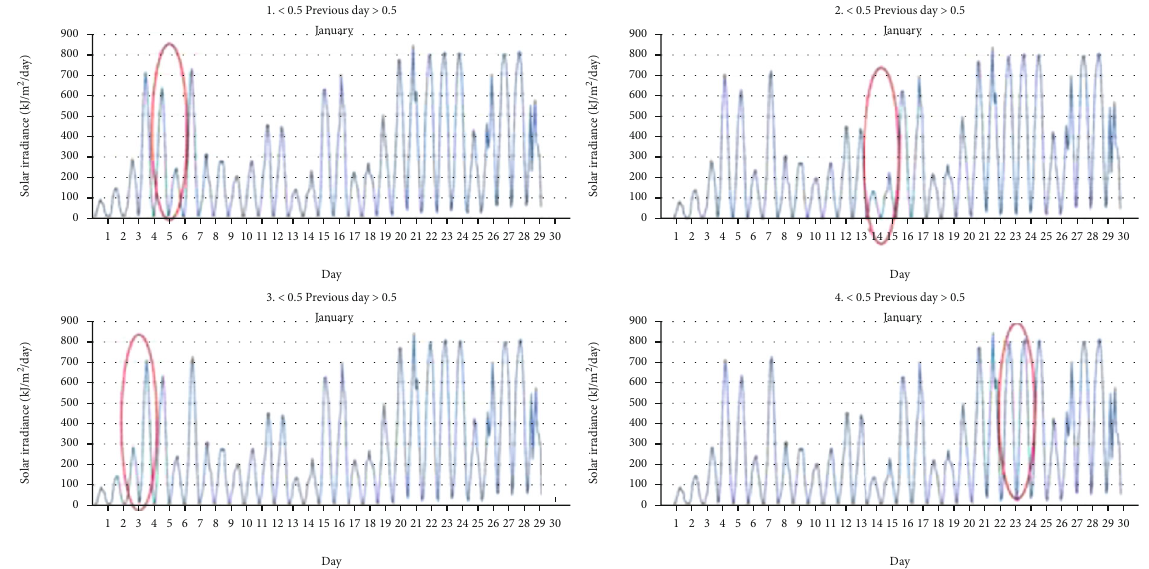
Figure 8: The four cloudy change situations quanti fi ed by the V Meteorological Station (kJ/m 2